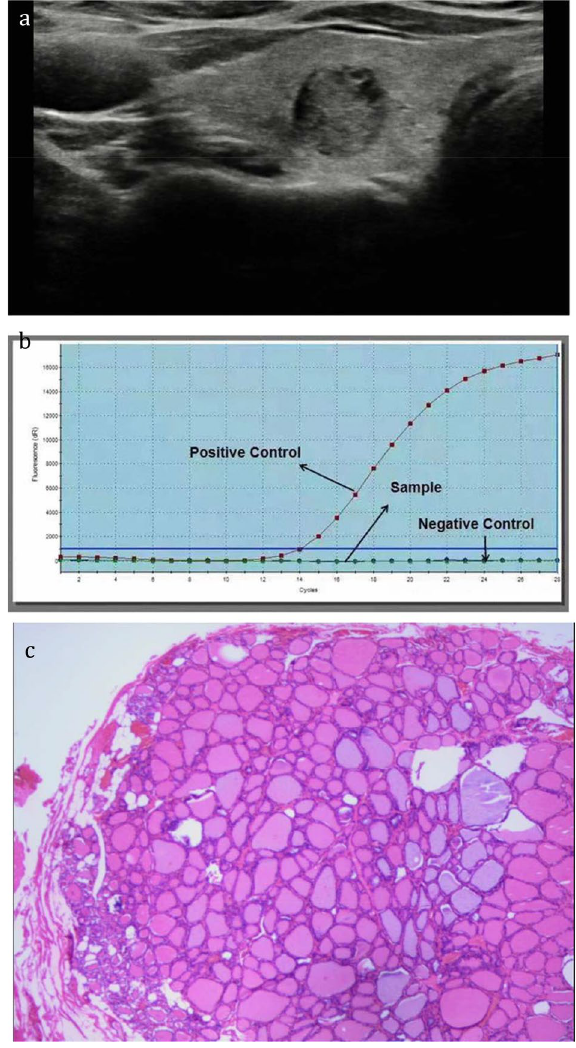
postoperative pathology. ( a ), the 2D sonogram classified as TIRADS 4a, ( b ), wild-type BRAF V600E gene, ( c ), nodular goiter confirmed by